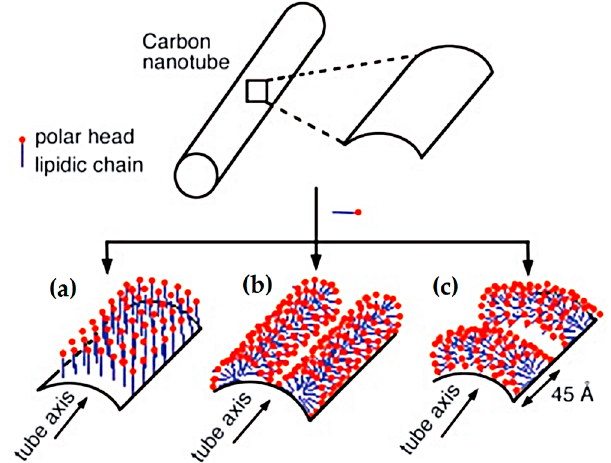
Figure 12. Different possible organizations of the SDS molecules on the surface of a CNT: ( a ) perpendicular adsorption; ( b ) half-cylinders oriented parallel to the tube axis; ( c ) half-cylinders oriented perpendicular to the tube axis [47]. Reproduced with permission of [47]. Copyright AAAS,